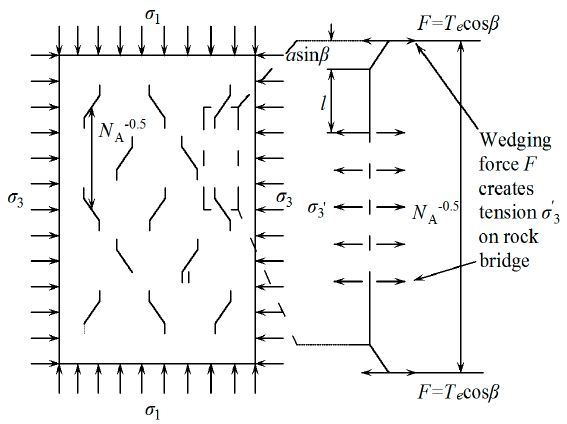
Figure 6. Sketch of interaction of multiple-cracks.